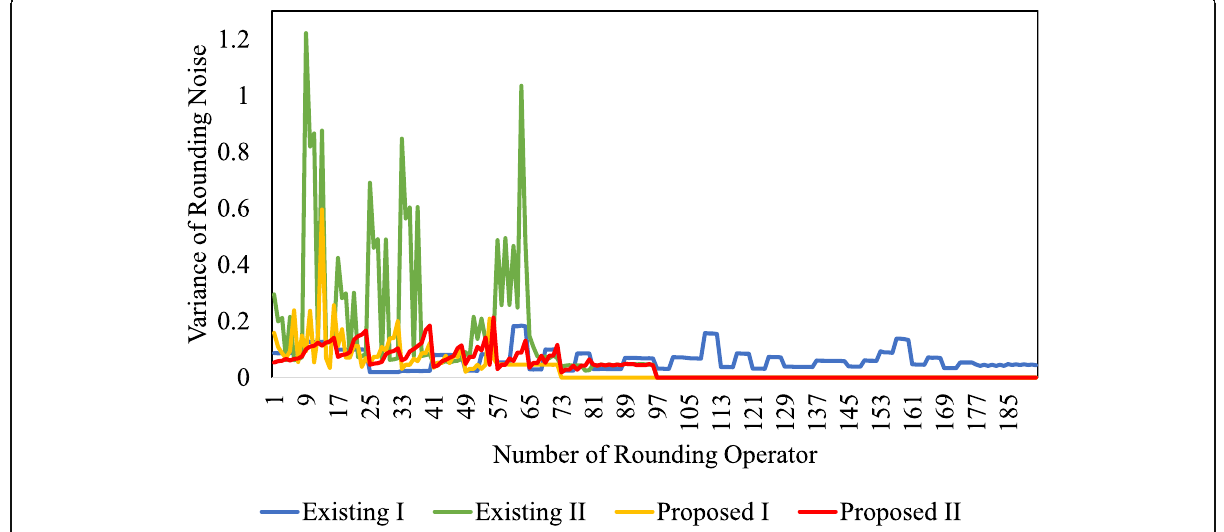
Fig. 18 Effect of one rounding operator for fMRI(II)